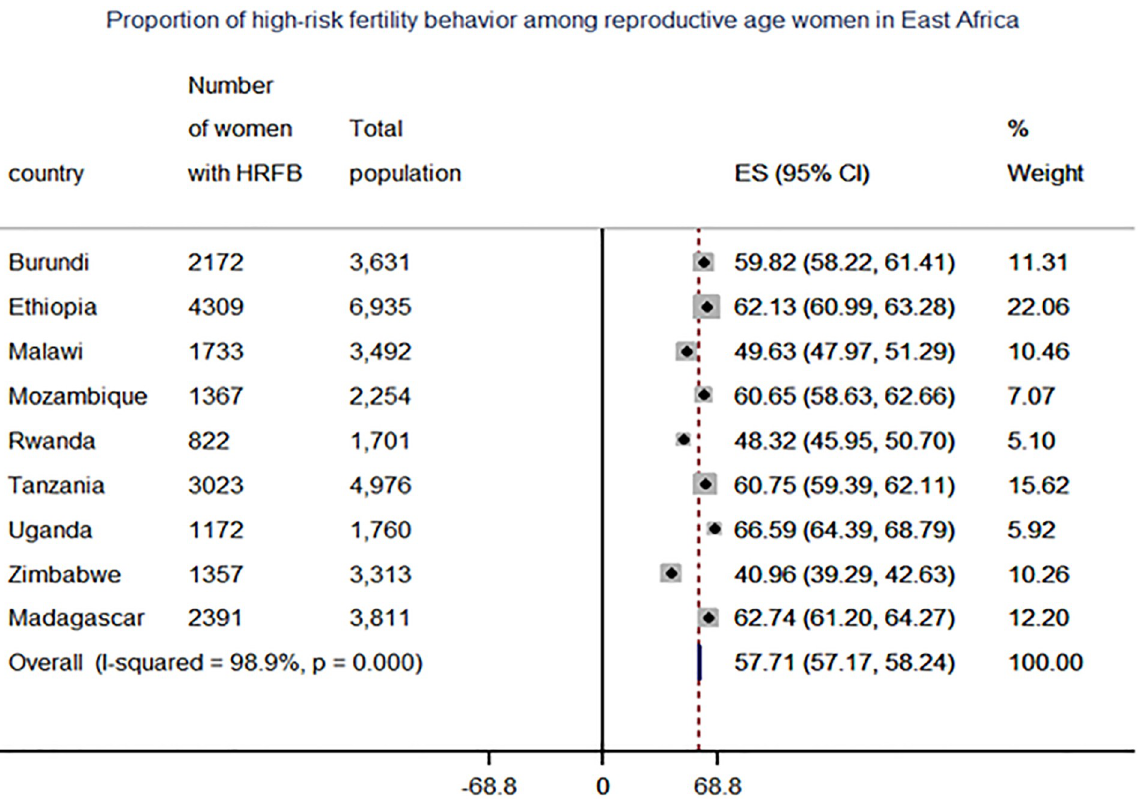
Fig 1. Forest plot of proportion of high-risk fertility behavior among reproductive-age women in East Africa countries.